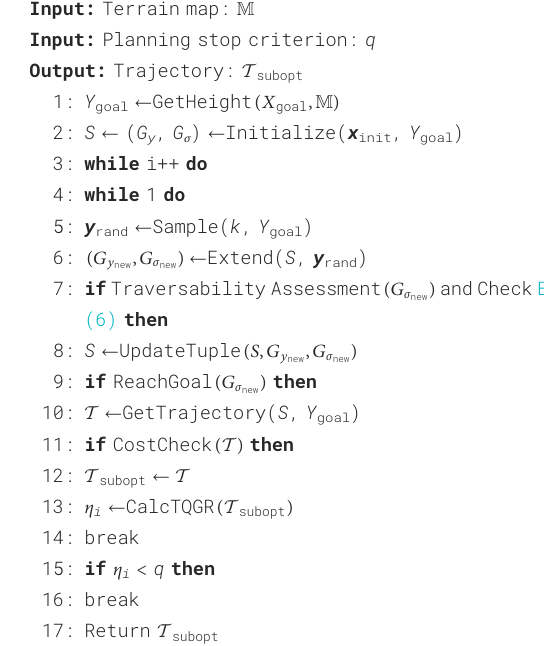
Algorithm 1. Anytime trajectory